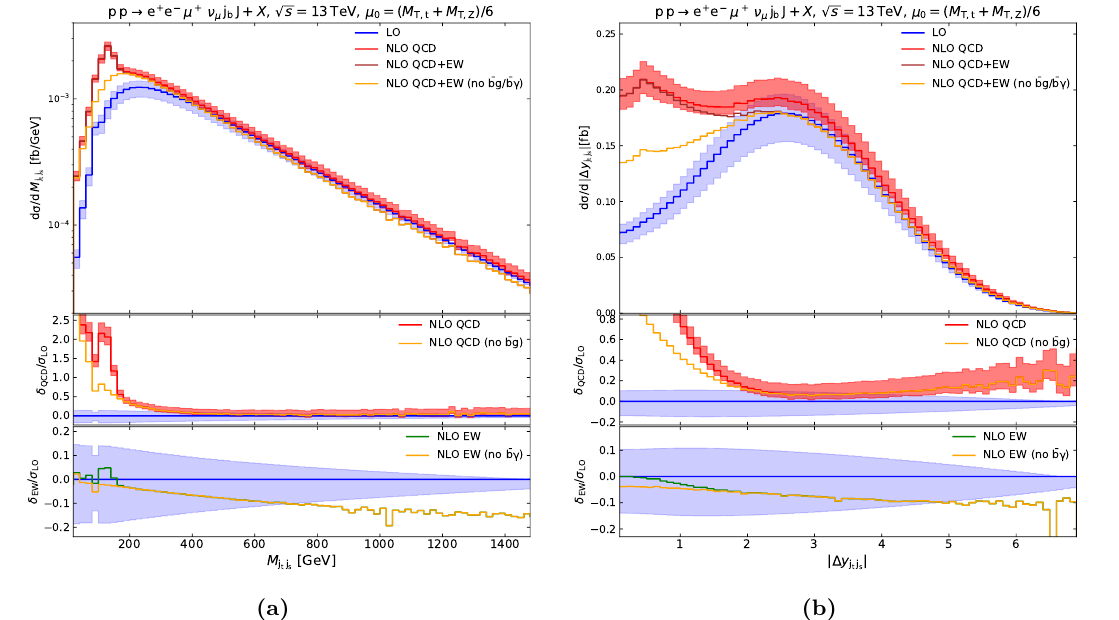
Figure 6. Invariant-mass and rapidity-separation distributions of the jet